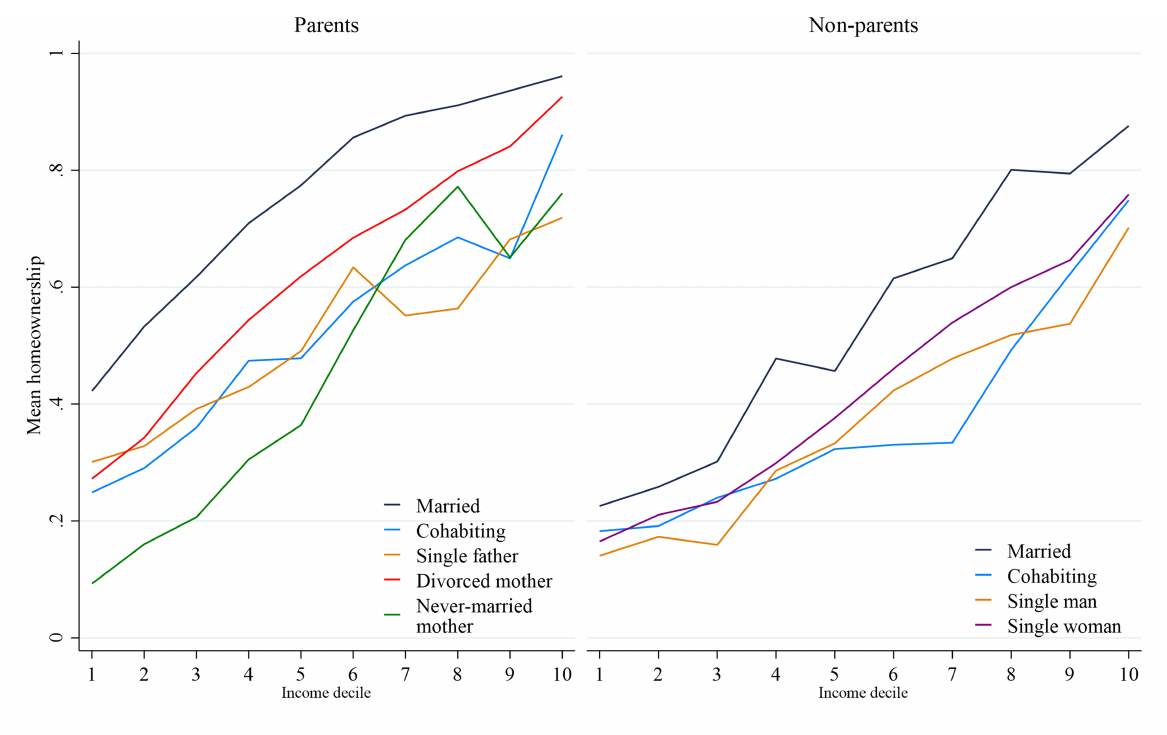
Figure 3: Homeownership by income decile and household